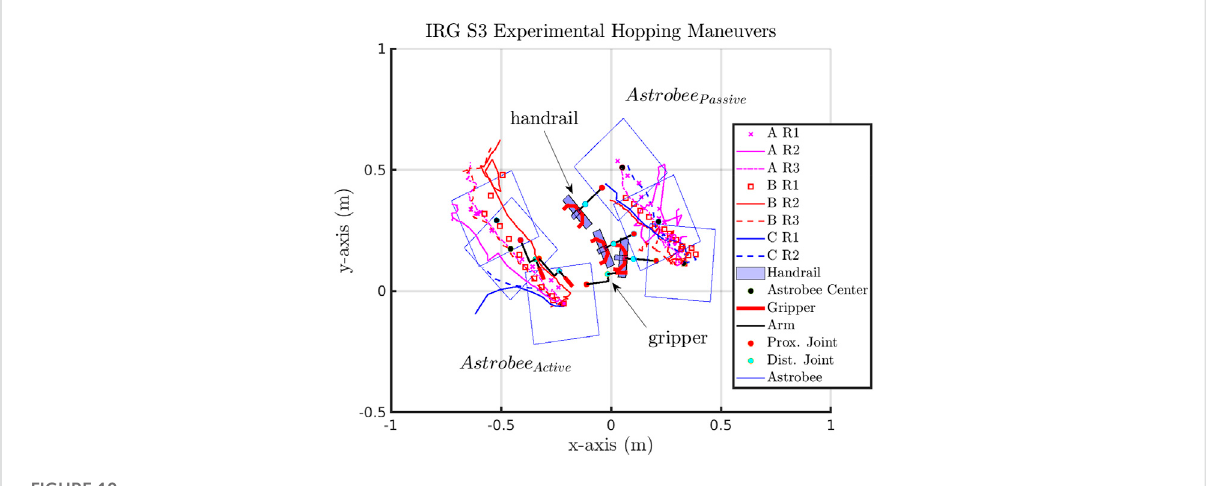
FIGURE 10 Illustration of the ground experiments at NASA Ames IRG, with the active Astrobee actuating its robotic arm in the plane and the passive Astrobee grasping the T-handrail in the upright